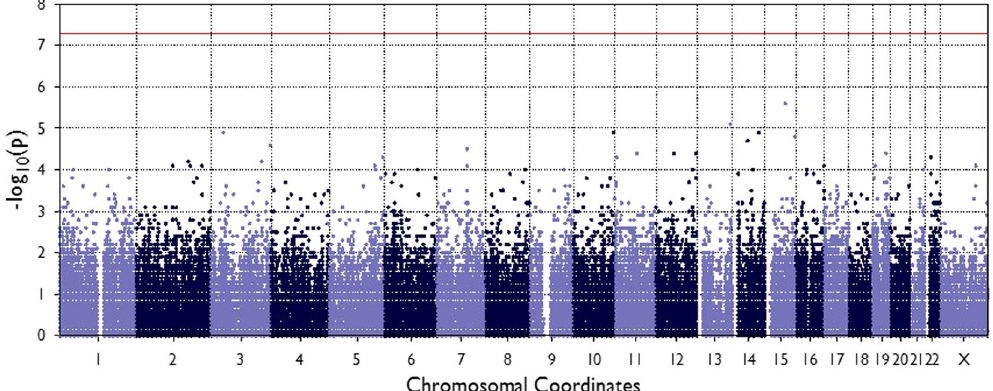
Figure 1. Manhattan plot for single variant analysis. The Y-axis shows − log 10 (p) values for common variants (MAF > 0.01) and the X-axis shows chromosomal positions for each variant. The threshold for statistical significance after correction for multiple testing (4.3 × 10 − 7 ) is shown by the red horizontal line.